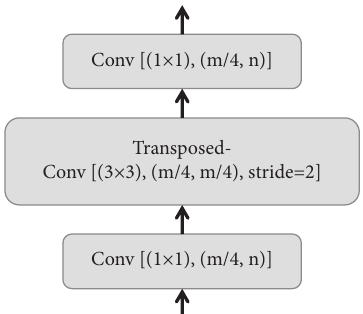
Figure 1: Residual network bottleneck structure with 1 × 1 convolution kernel.